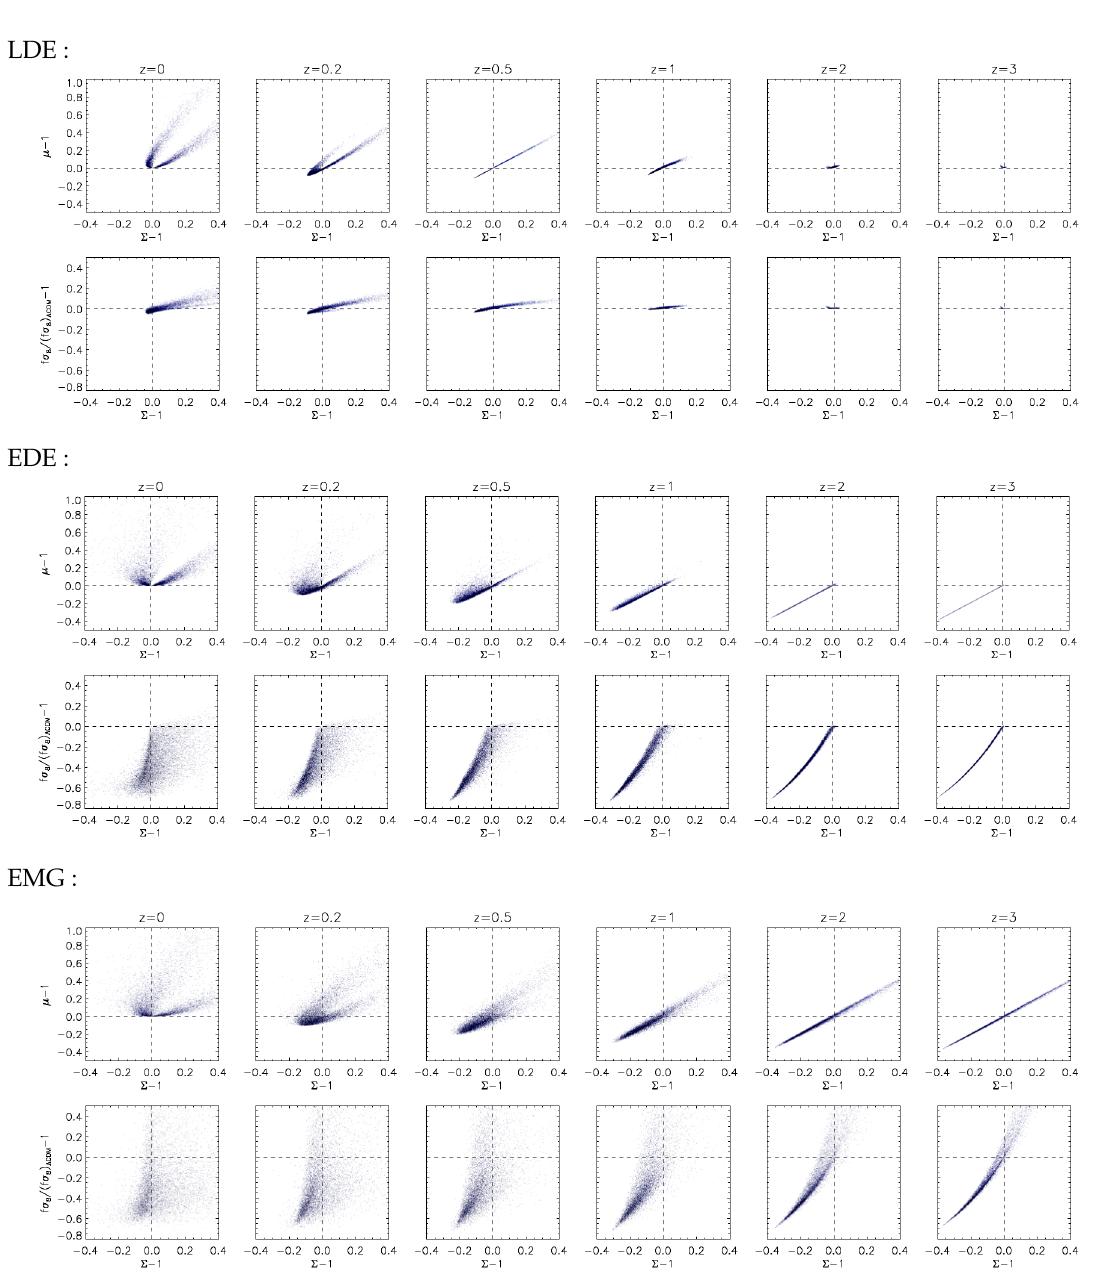
Figure 3. We display the same correlations as in Figure 1 however here all the models bear e 4 = 0 hence c T = c , at all